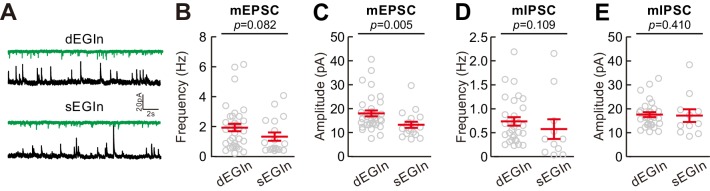
Comparison of mEPSCs and mIPSCs between dEGIns and sEGIns at P5–7.(A) Representative traces of inward mEPSCs (green traces) and outward mIPSCs (black traces) recorded in dEGIns and sEGIns of the somatosensory cortex. Scale bars: 20 pA (vertical), 2 s (horizontal). (B–E) Histograms of the frequencies (B) and amplitudes (C) of mEPSCs, and the frequencies (D) and amplitudes (E) of mIPSCs in dEGIns and sEGIns of the somatosensory cortex. Detailed statistical analysis, detailed data, and exact sample numbers are presented in the Figure 3—source data 1. Error bars indicate mean ± SEM.